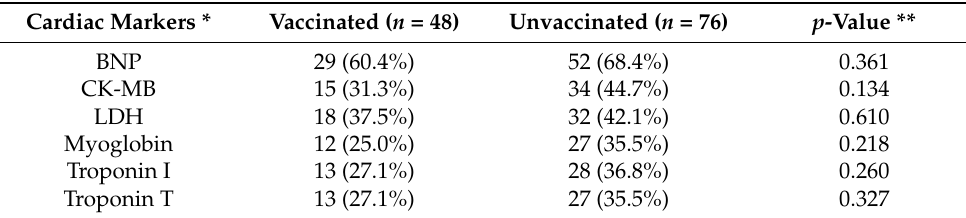
Table 4. Comparison of cardiac markers between vaccinated and unvaccinated heart failure patients with COVID-19 at